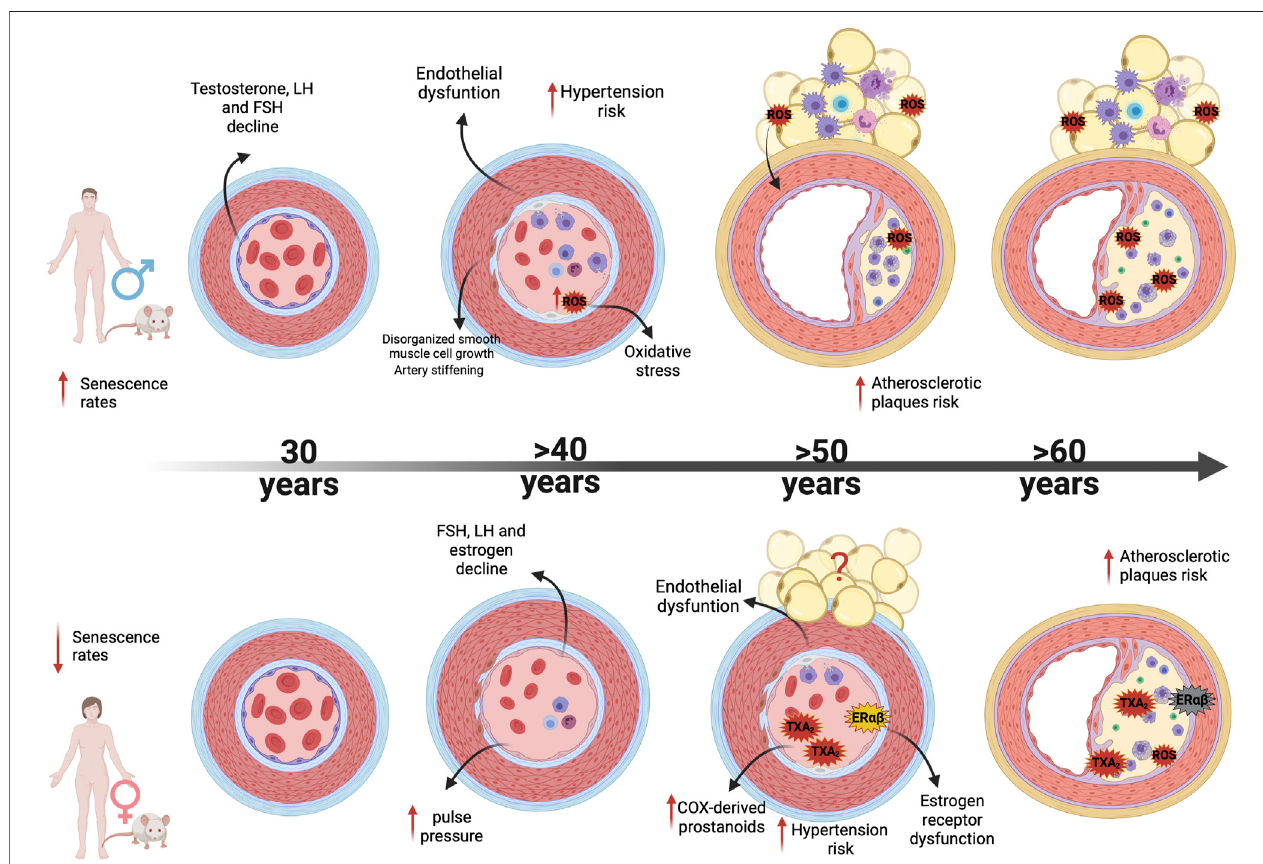
FIGURE 2 | Mechanisms associated with sex differences in vascular aging. Figure illustrates vascular and PVAT age-associated alterations observed in male and female; from differences in age onset of vascular dysfunction (males show higher senescence rates than females) to different mechanisms of endothelial dysfunction, vascular remodeling and oxidative and in fl ammatory processes as men and women age increases. Abbreviations: LH, Luteinizing Hormone; FSH, Follicle-stimulating hormone; TXA2, Thromboxane; ER α , Estrogen receptor alpha; ER β , Estrogen receptor; ROS, Reactive Oxygen Species.